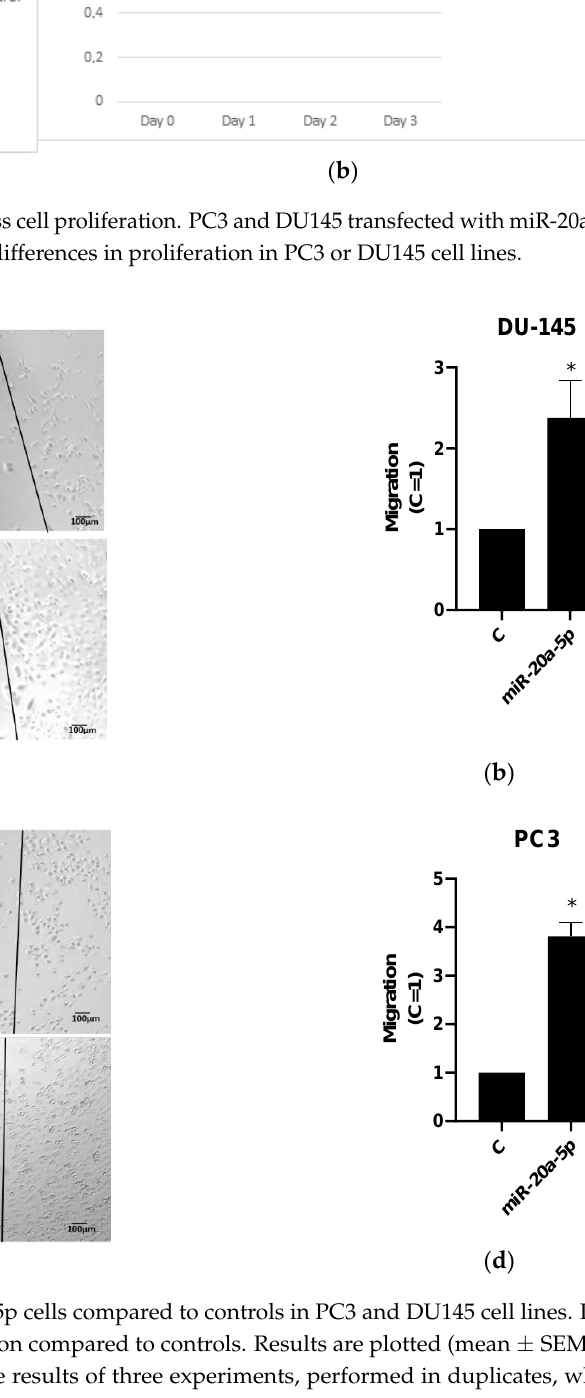
Figure 2. PC3 ( a ) and DU145 ( b ) cell lines were used to assess cell proliferation. PC3 and DU145 transfected with miR-20a- 5p were compared to control cells. There were no significant differences in proliferation in PC3 or DU145 cell lines.